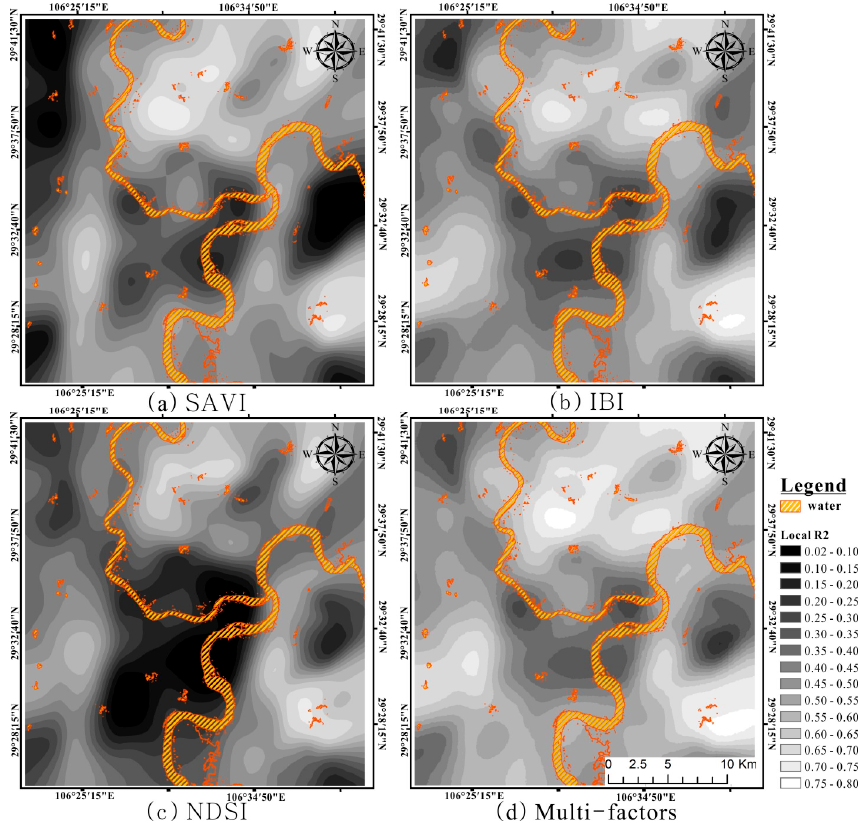
Figure 4. The spatial distribution of the local R 2 in the GWR models at a spatial resolution of 30 m, ( a ) for the LST–SAVI model; ( b ) for the LST–IBI model; ( c ) for the LST–NDSI model; and ( d ) for the multi-factor model (using the SAVI, IBI, and NDSI as the explanatory variables simultaneously). Moreover, the yellow area represents water.